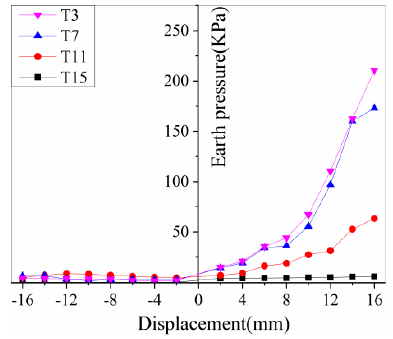
Figure 9. Relationship between earth pressure and displacement load.